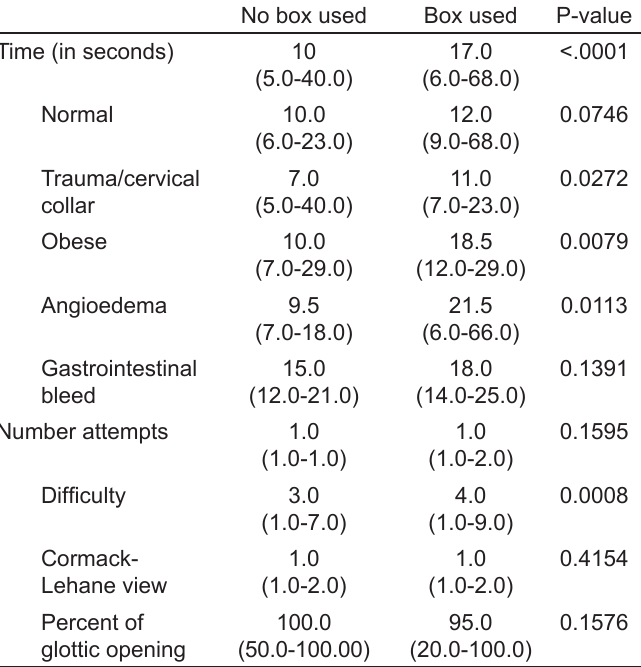
Table 2. Time to intubation results, median